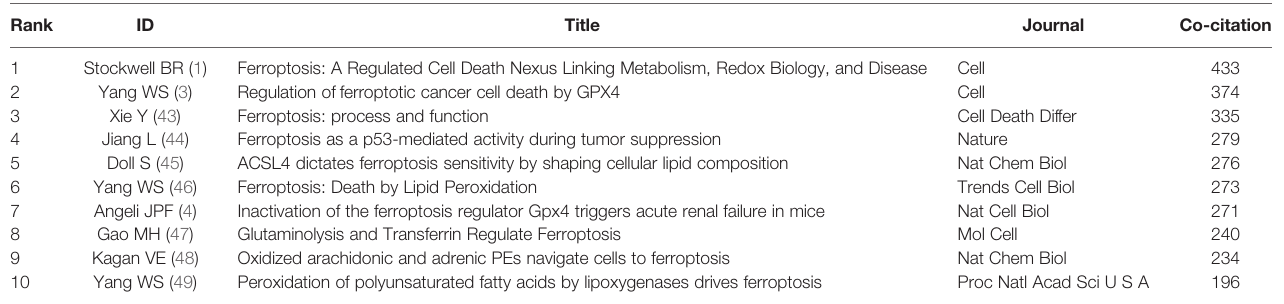
TABLE 6 | Top 10 co-cited references for ferroptosis